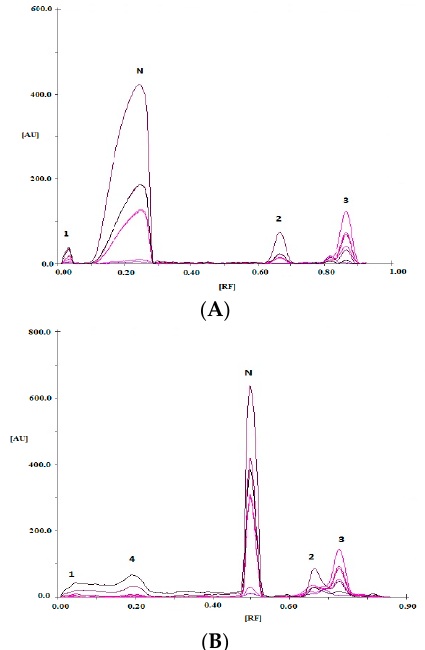
Figure 4. The comparison of peak areas (in %) of naproxen (N), which was irradiated to UV light (254 nm) from above in solutions II, III, IV, V, VI for 10 h. Substances (S1–S6 being the main products of its degradations and the standard of naproxen, mobile phase: TOL-ACE-CHL (2:5:12, v/v/v) ( A ) and AcOH-Hex-ACE (0.10:10:10, v/v/v) ( B ), where S2—naproxen ethyl ester; S1, S3, S4, S5, S6—unknown degradation products of chemical transformation of naproxen.